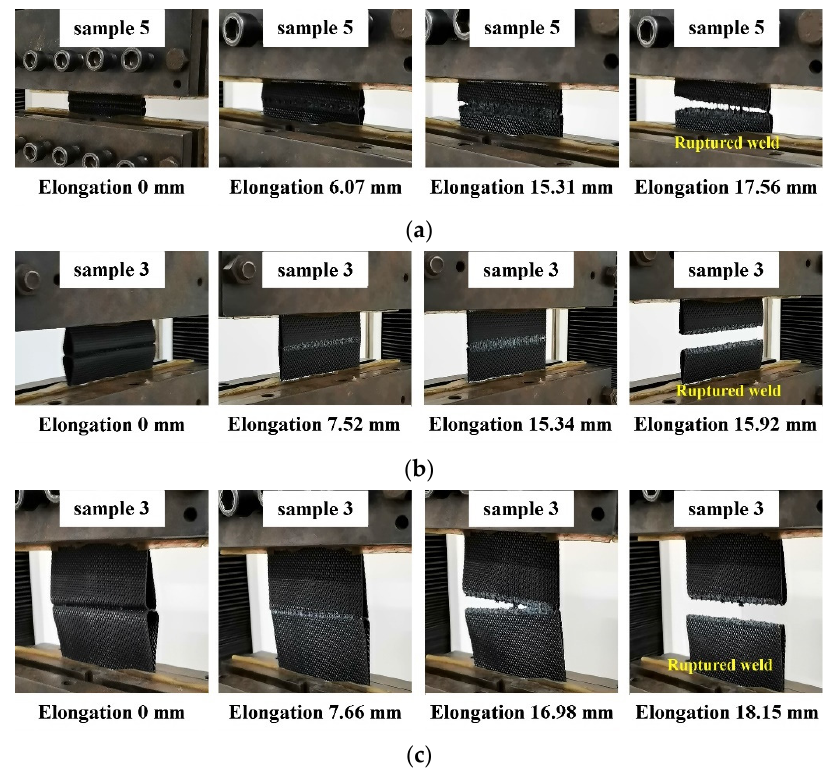
Figure 17. Failure modes of the junction subjected to a splitting force under various clamping distances: ( a ) 25 mm, ( b ) 50 mm, ( c ) 100 mm.